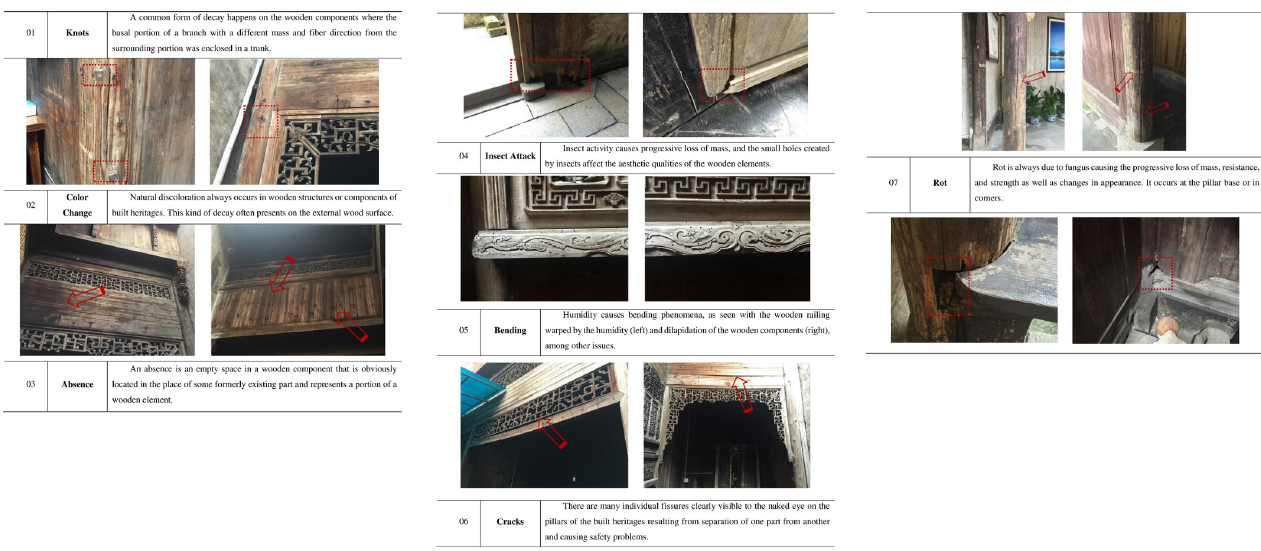
Fig 5. Main decay phenomena of the wooden components of the traditional